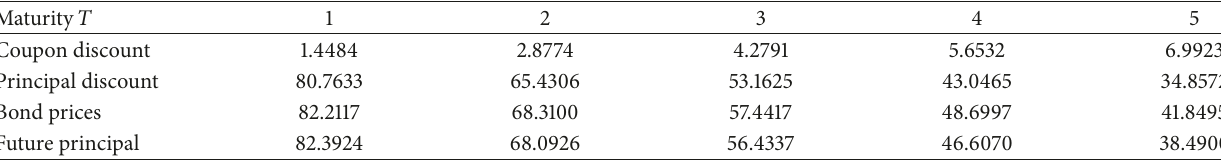
Table 5: The sensitivity of maturity to cat bond when 𝜆 = 3 .